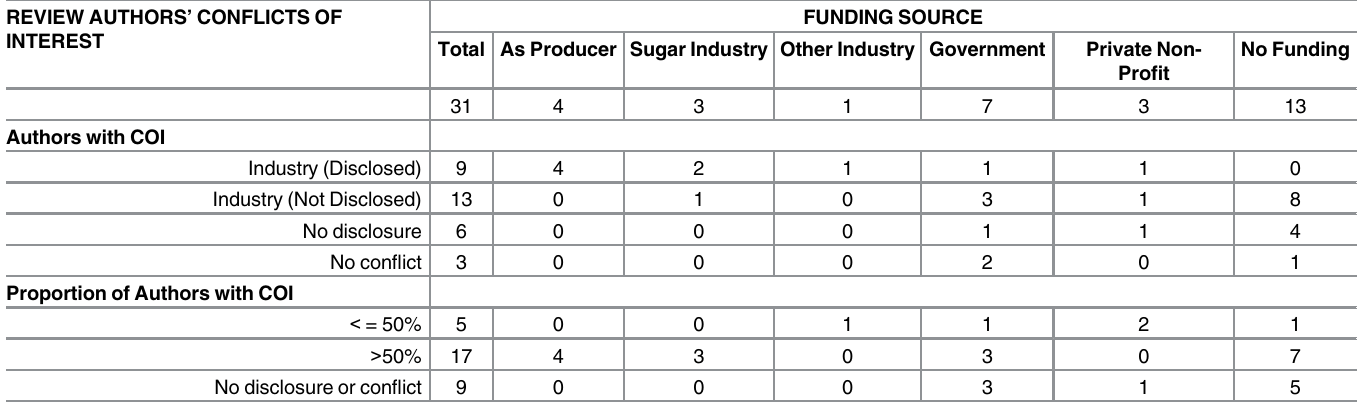
Table 4. Authors ’ conflicts of interest by review funding source (n =